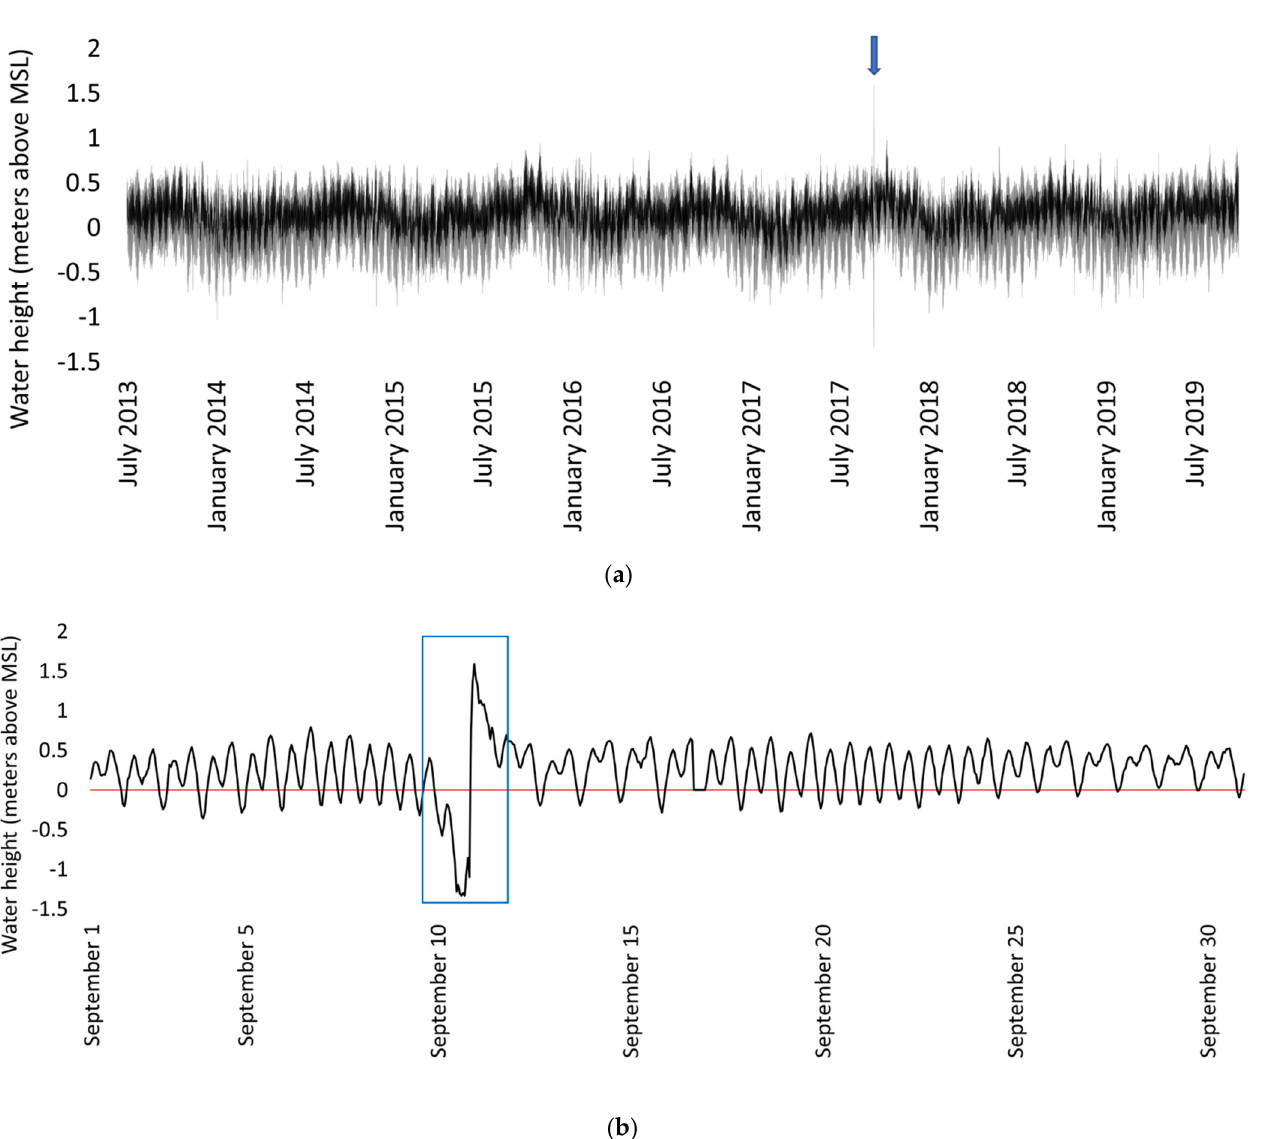
Figure 10. Water level in meters above mean sea level (MSL) from USGS station in the Gulf of Mexico on the Naples Pier ( a ) between July 2013 (pre-hurricane sampling) and July 2019 (post-hurricane sampling) with Hurricane Irma water level indicated by the arrow and ( b ) September 2017 water level with a box around hurricane Irma landfall.